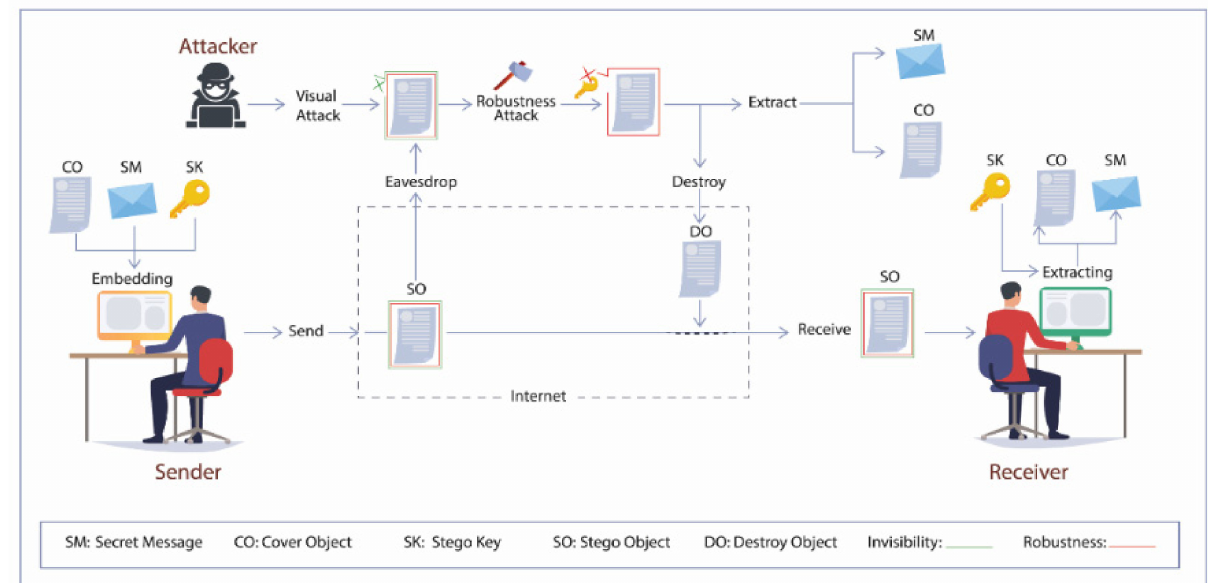
Figure 1. Scenario of